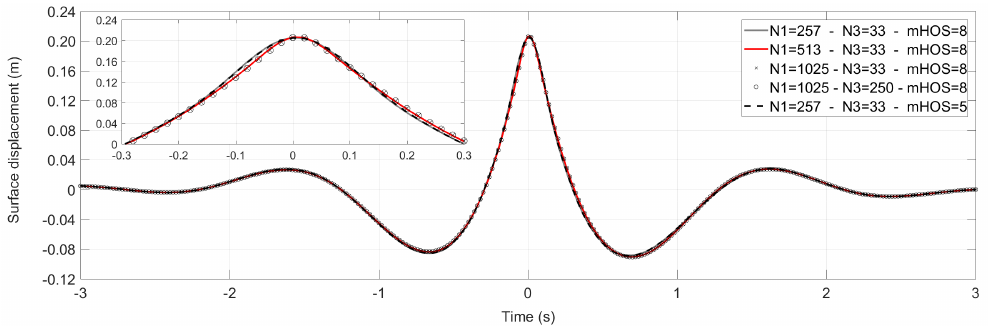
Figure 5. Convergence analysis for the HOS-NWT.